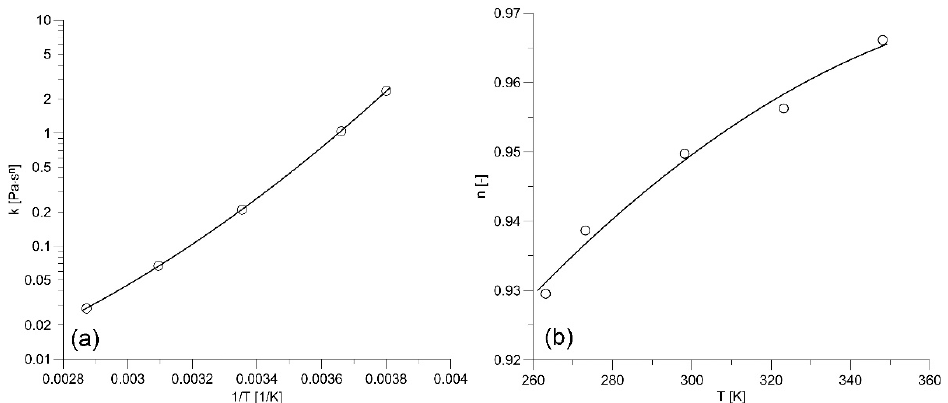
Figure 2. Parameters of the power model for the base oil 10W40; (o) data points, (——) polynomial approximation: ( a ) consistency index, ( b ) flow behavior index.